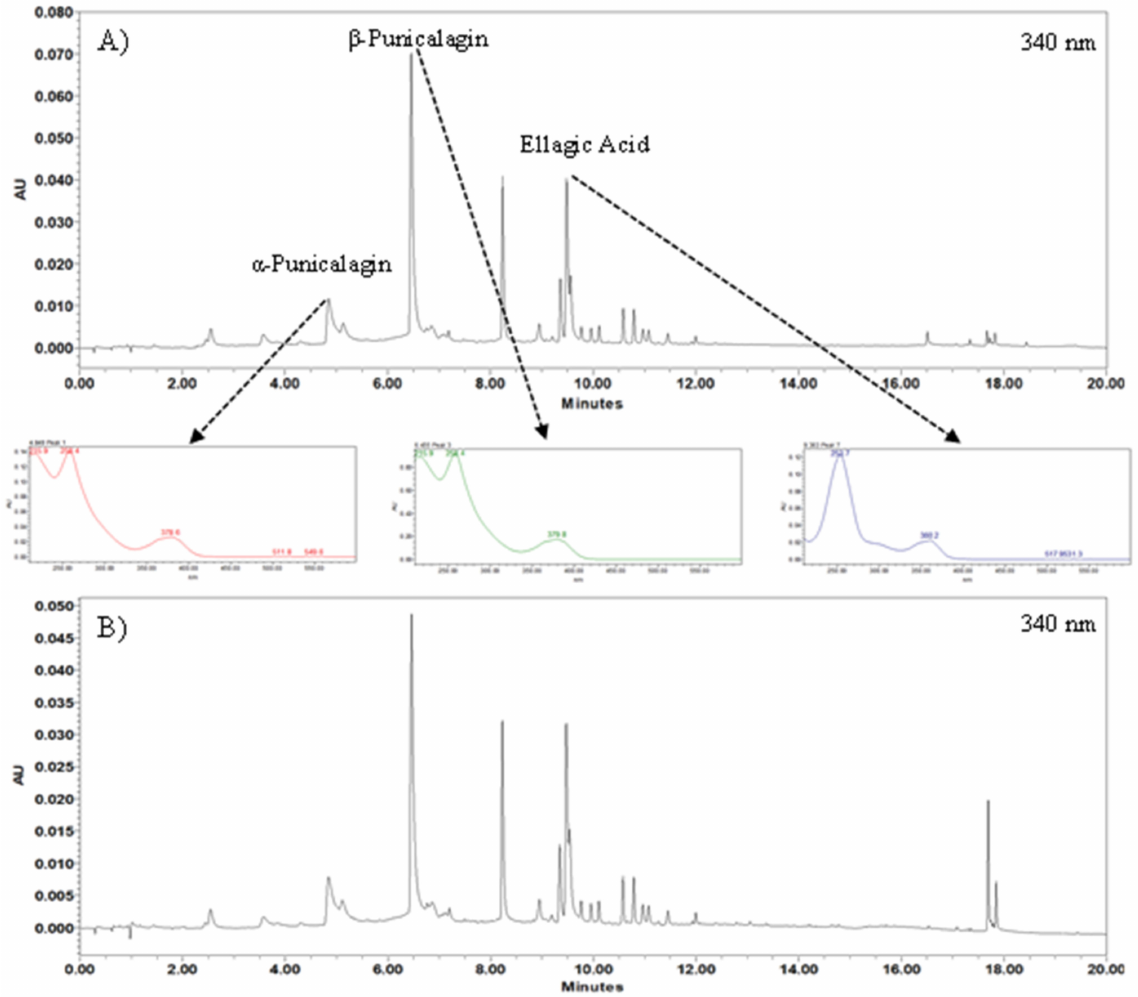
Figure 3. Representative chromatograms at 340 nm of the ( A ) extract 1 and ( B ) extract 2 obtained with the highest extraction